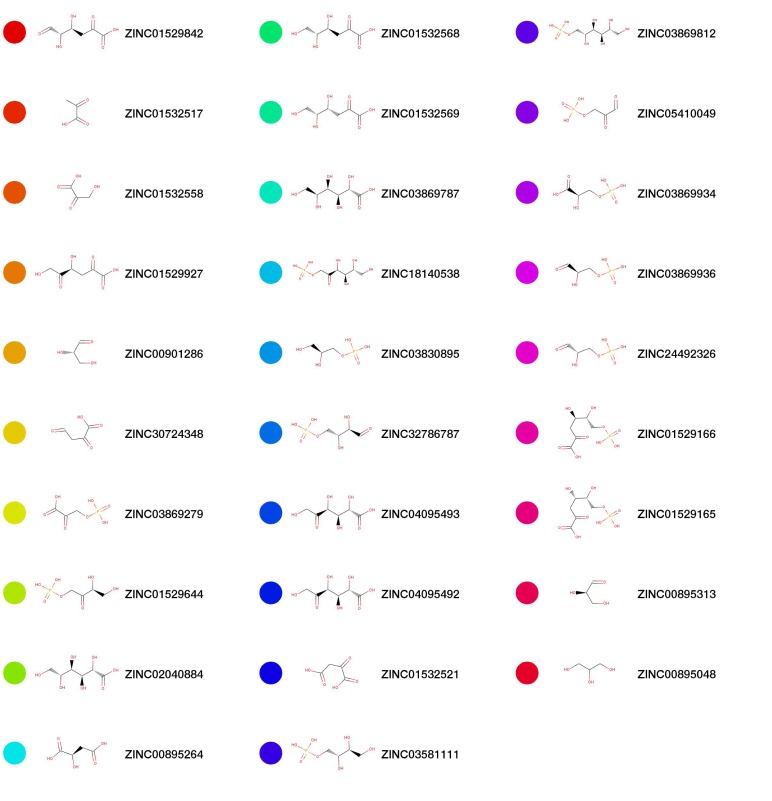
Chemical structures for top scoring pathway model predictions.The colored nodes correspond to the coloring in Figure 3..